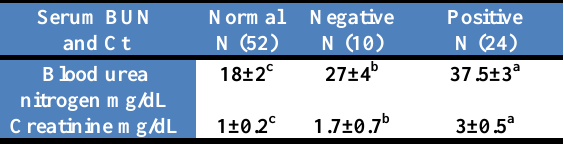
Table, 4: Detection of blood urea nitrogen and serum creatinine in normal control and negative and positive bacterial urine culture samples of slaughtered buffaloes (Mean